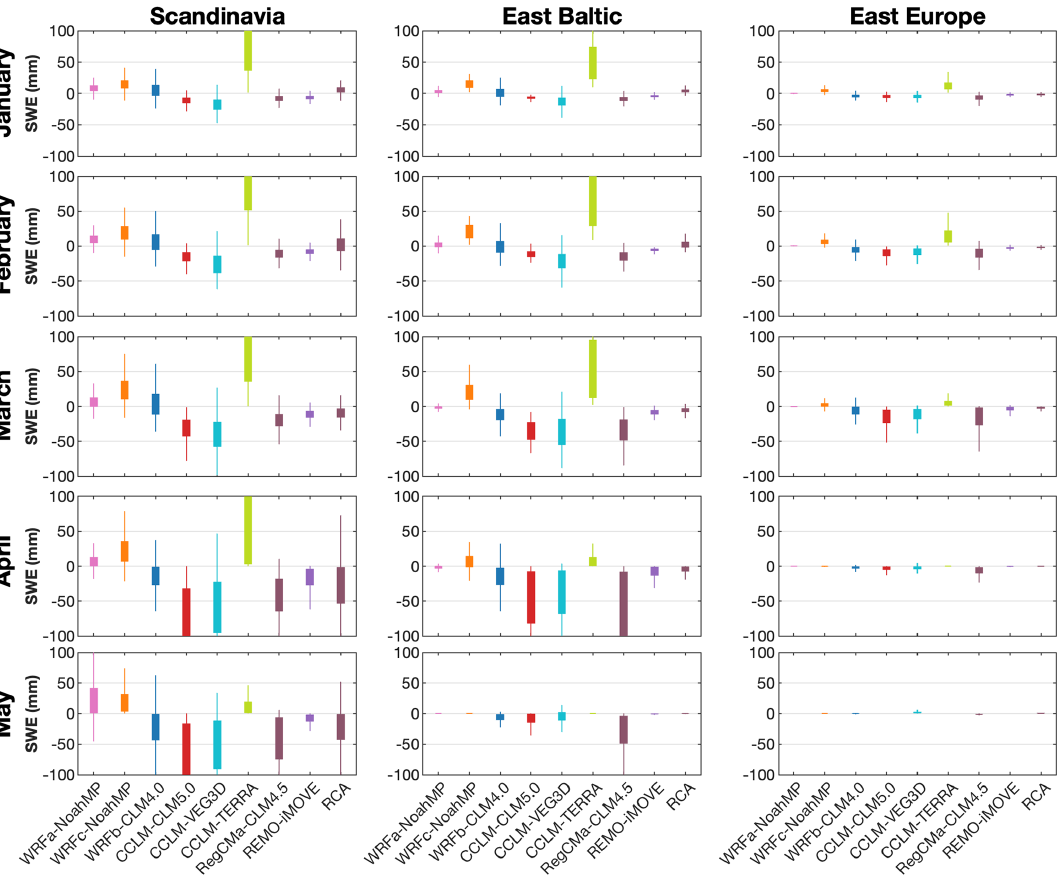
Figure 4. Impact of afforestation (FOREST − GRASS) on snow water equivalent (SWE) simulated by the LUCAS models. The box plots indicate the spatial variability in the difference between the FOREST and GRASS experiments for each month from January to May (see y axis). Only differences that are statistically significant at the 95% confidence level are considered. Statistical significance was determined using Student’s t